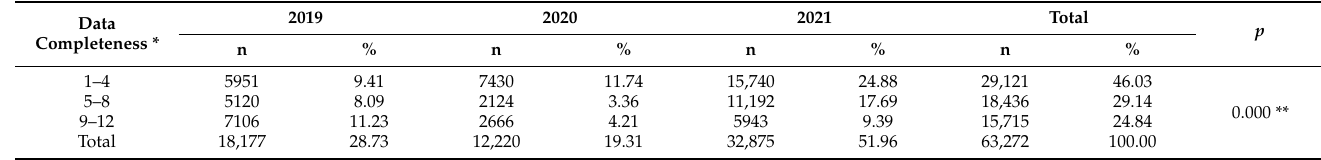
Table 1. Total data completeness analysis each year.